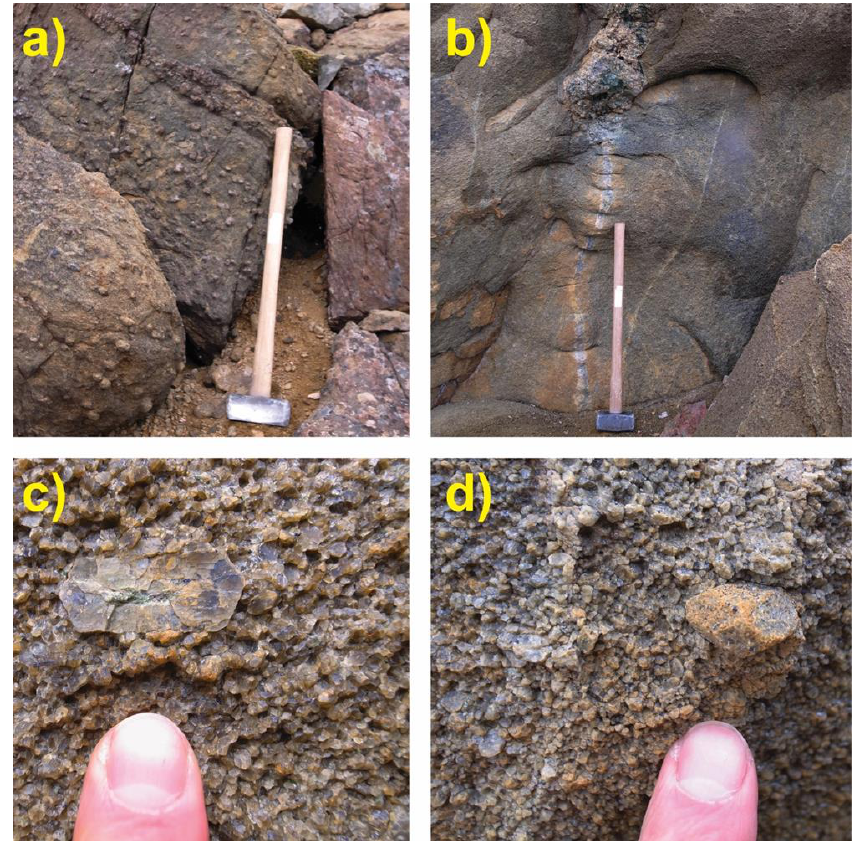
Figure 2. Field photos from the Seqi Ultramafic Complex. ( a ) Poikilitic dunite showing isolated poikiloblasts of coarse orthopyroxene with diameters up to 5 cm. ( b ) Example of actinolite-rich metasomatic vein in dunite. ( c ) Porphyroblastic dunite with a large (3 cm) euhedral olivine crystal, which is broken in half showing a core of actinolite. ( d ) Porphyroblastic dunite showing unbroken euhedral olivine crystal. Please see Szilas et al. [5] for further details on textures and rock types. The minimum age of the Seqi complex is constrained by an intrusive tonalitic sheet at 2978 ± 8 Ma [5], coincident with the transition from continental crust formation to regional granulite facies